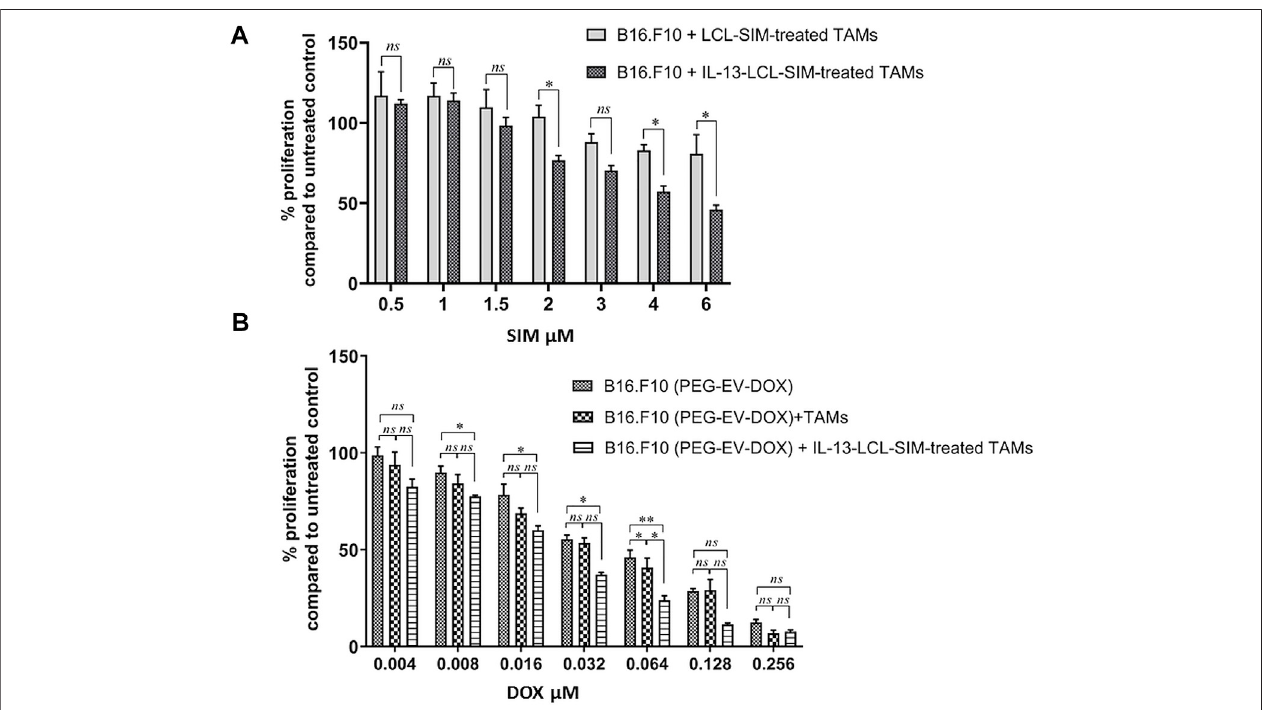
FIGURE 2 | Antiproliferative effects of sequential administration of IL-13-LCL-SIM and PEG-EV-DOX on B16.F10 cell proliferation. (A) B16.F10 cell proliferation in co-culture with either LCL-SIM or IL-13-LCL-SIM-treated M2 macrophages (treated with various concentrations 24 h prior to adding both cell types in co-culture). (B) EffectsofvariousconcentrationsofDOXincorporatedinPEG-EV-DOXontheproliferationofB16.F10melanomacellsmonocultured,co-culturedwithM2macrophages or with IL-13-LCL-SIM-treated M2 macrophages (treated with 2 μ M SIM encapsulated in IL-13-LCL-SIM 24 h prior to adding both cell types in co-culture). The data represent mean ± SD of triplicate measurements. The unpaired t -test was used to compare the effects of different treatments to LCL-treated/-untreated B16.F10 controls ; ns — not signi fi cant; p > 0.05; *, p < 0.05; and **, p < 0.01.